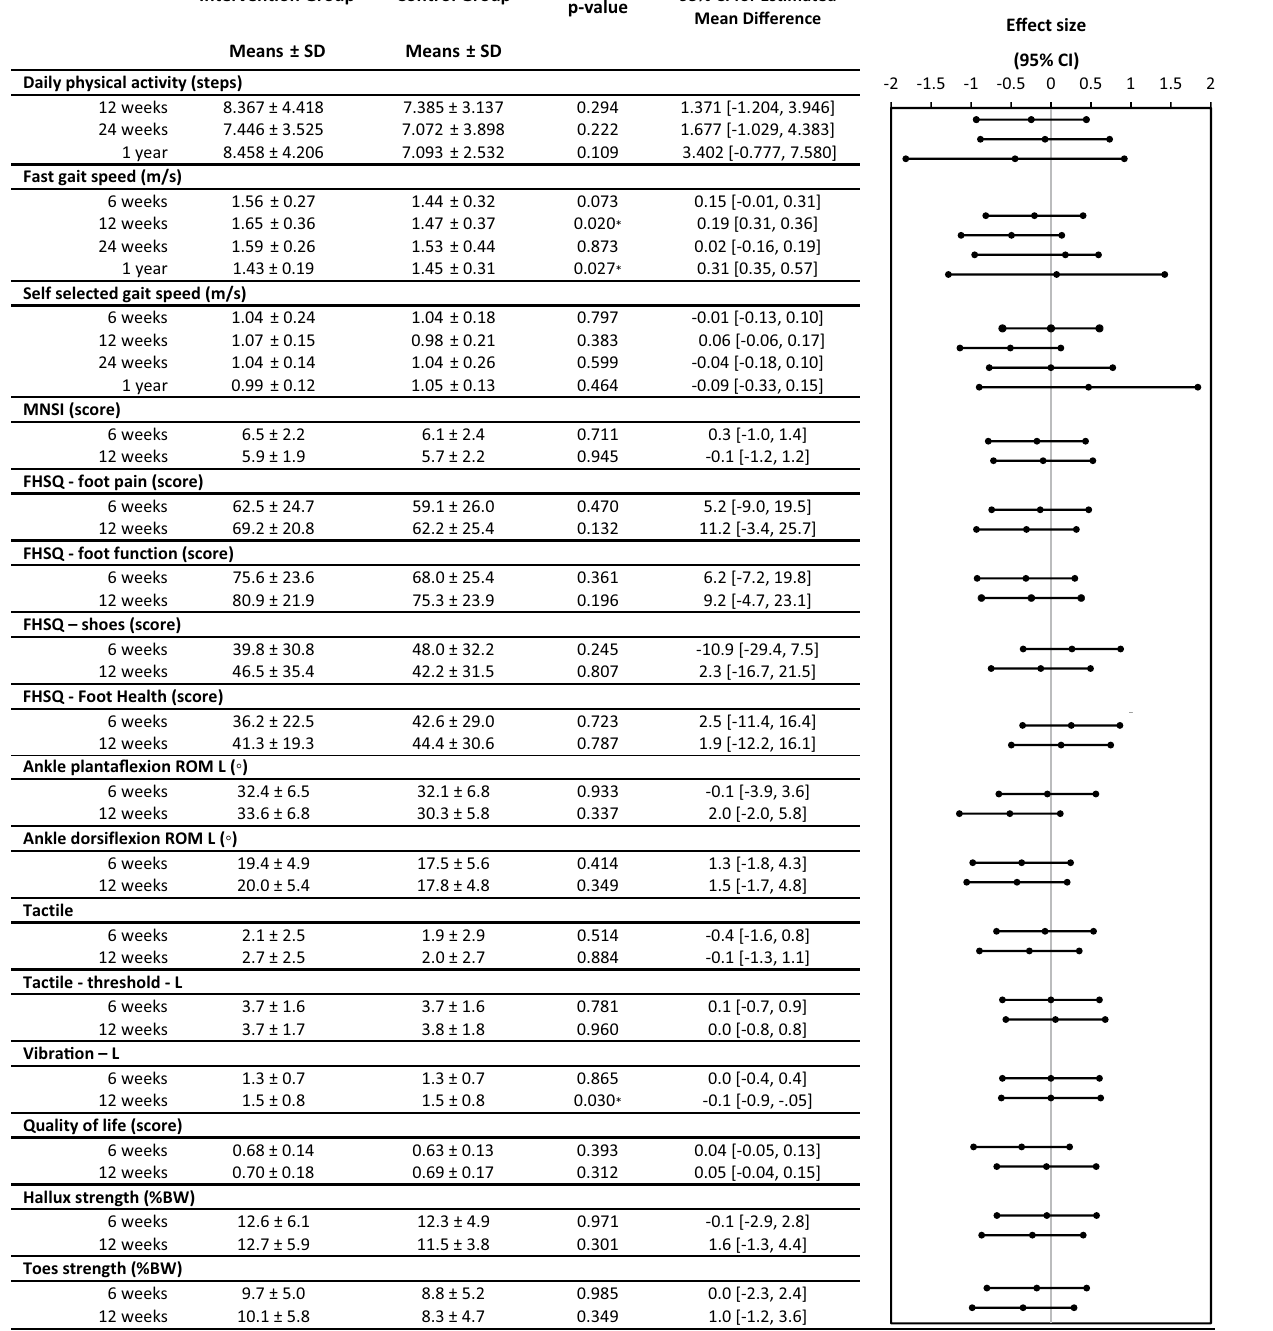
Table 2. Secondary and primary outcomes from intervention group and control